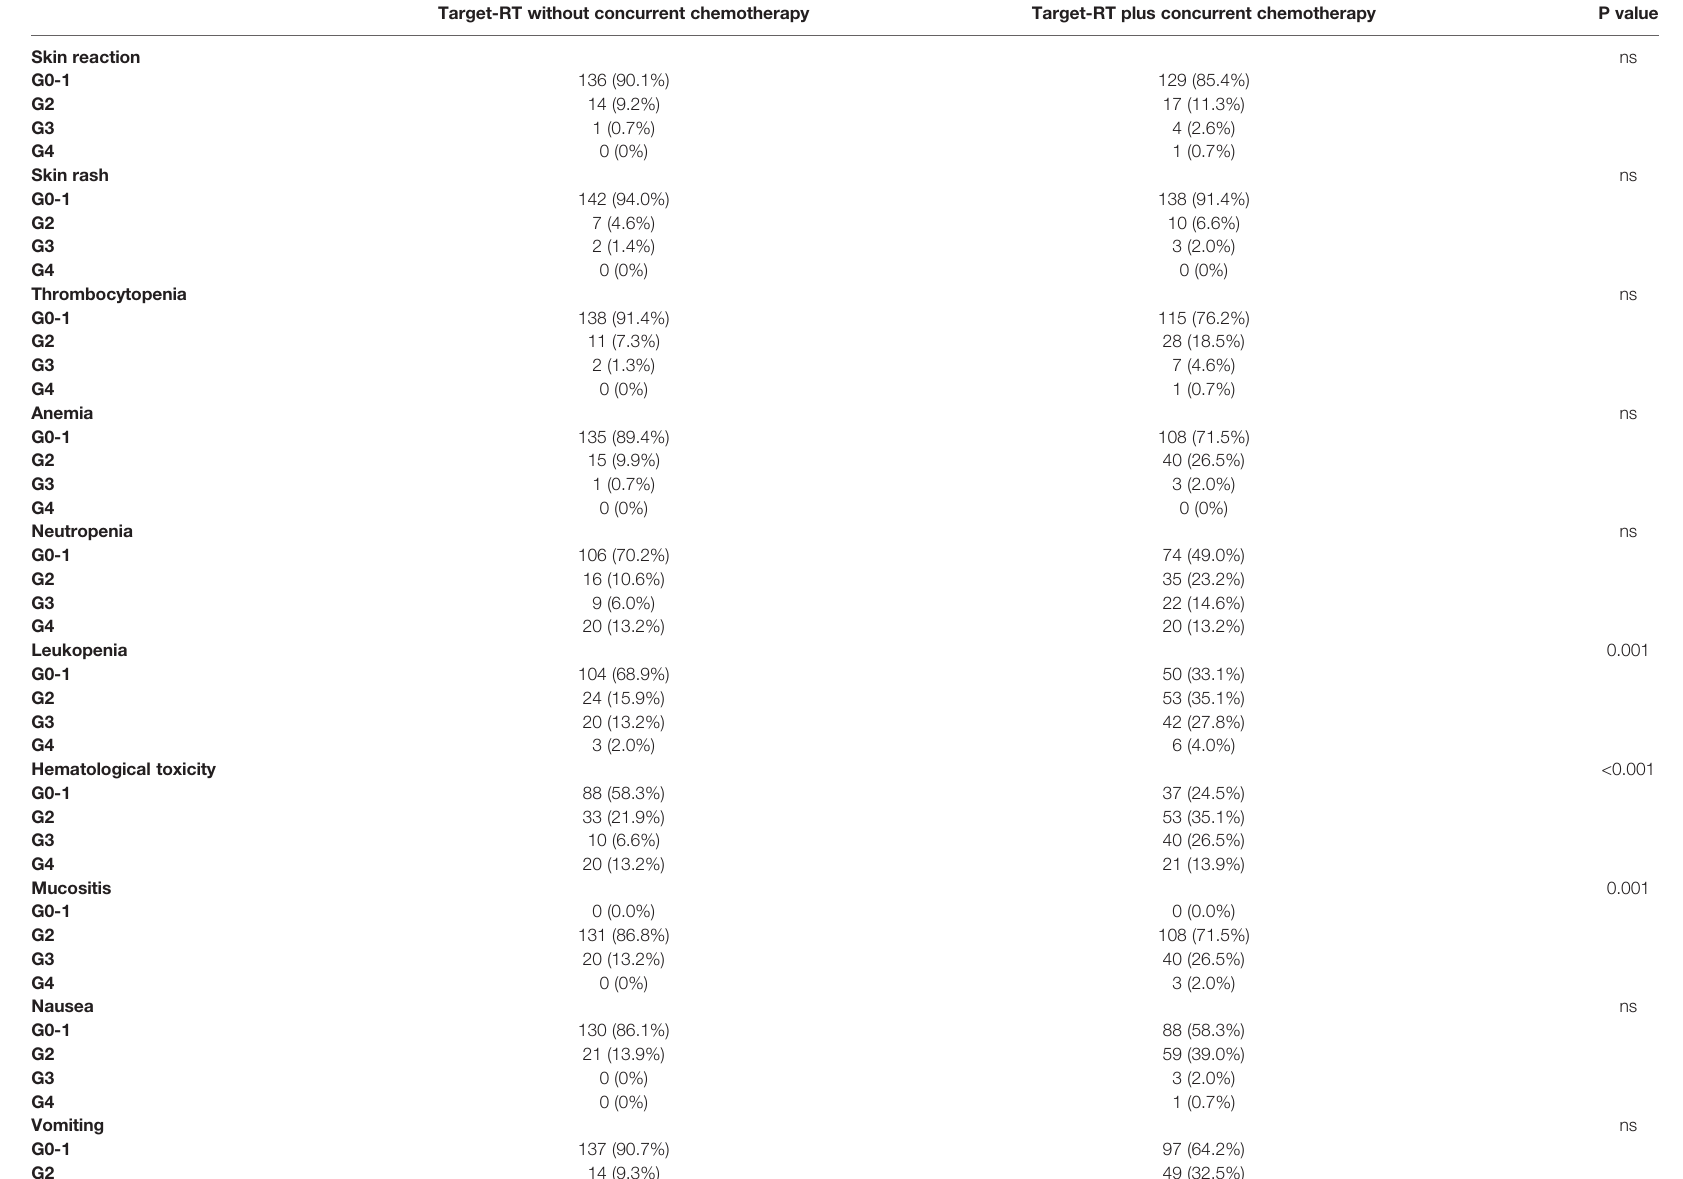
TABLE 1 | Acute toxicities in NPC patients receiving different treatment